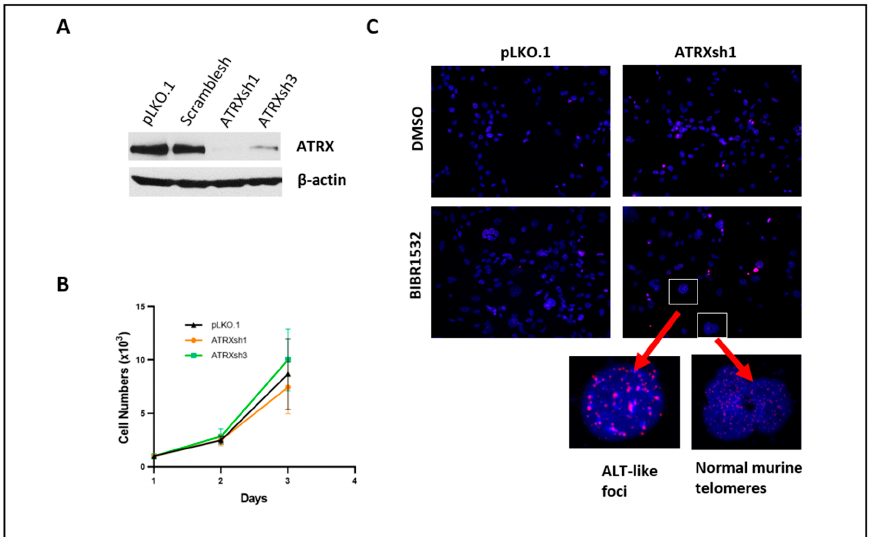
Figure 1. Atrx knockdown in Nf1 +/ − Trp53 +/ − murine glioma cell line 130G#3. Reduction in Atrx expression using Atrx shRNAs was performed ( A ) and there were no significant effects on cell growth ( B ). Development of ultrabright telomere foci, reminiscent of ALT, after Atrx knockdown and treatment with the telomerase inhibitor, BIBR1532 for 39 days ( C ). Empty lentiviral vector (pLKO.1) and scramble shRNA were used as controls.